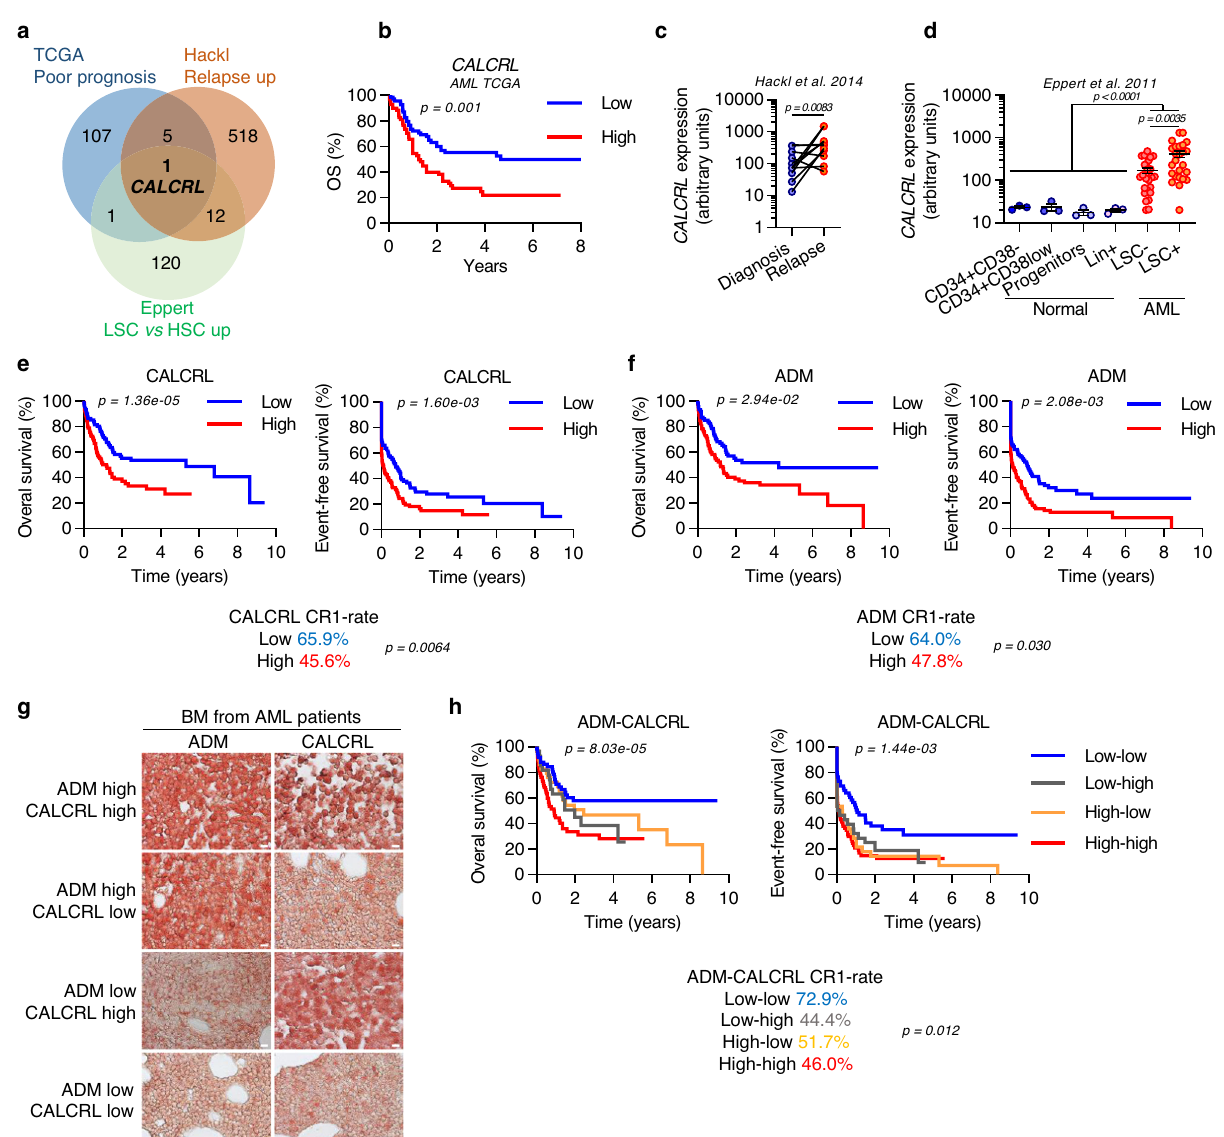
Fig. 1 Expression of CALCRL and its ligand adrenomedullin and impact on patient outcome in AML. a Genes overexpressed and associated with poor prognosis, relapse, or LSC vs HSC according to TCGA, Hackl et al. 7 and Eppert et al. 2 studies, respectively. b Impact of CALCRL gene expression on overall survival in the TCGA cohort (Log-rank (Mantel-Cox) test). Data were dichotomized according to median value for visualization purpose. c CALCRL expression at diagnosis and relapse after intensive chemotherapy according to Hackl et al. 7 (unpaired t -test). d CALCRL gene expression in normal compartments CD34 + CD38 − , CD34 + CD38 low , progenitors, and Lin + compared with leukemic LSC − and LSC + compartments according to Eppert et al. 2 (unpaired t -test) e, f Overall survival (OS) and event-free survival (EFS) according to CALCRL and ADM H-scores. OS and EFS were regressed against CALCRL and/or ADM H-scores using univariate or multivariate Cox model. Data were dichotomized for visualization purpose. g Representative IHC micrographs of CALCRL and ADM expression in pretherapeutic BM from AML patients. A picture of each primary sample was taken to make the quanti fi cations. Scale bars correspond to 10 µ m. h OS and EFS according to CALCRL and ADM H-scores. OS and EFS were regressed against CALCRL and/ or ADM H-scores using univariate or multivariate Cox model. Data were dichotomized for visualization